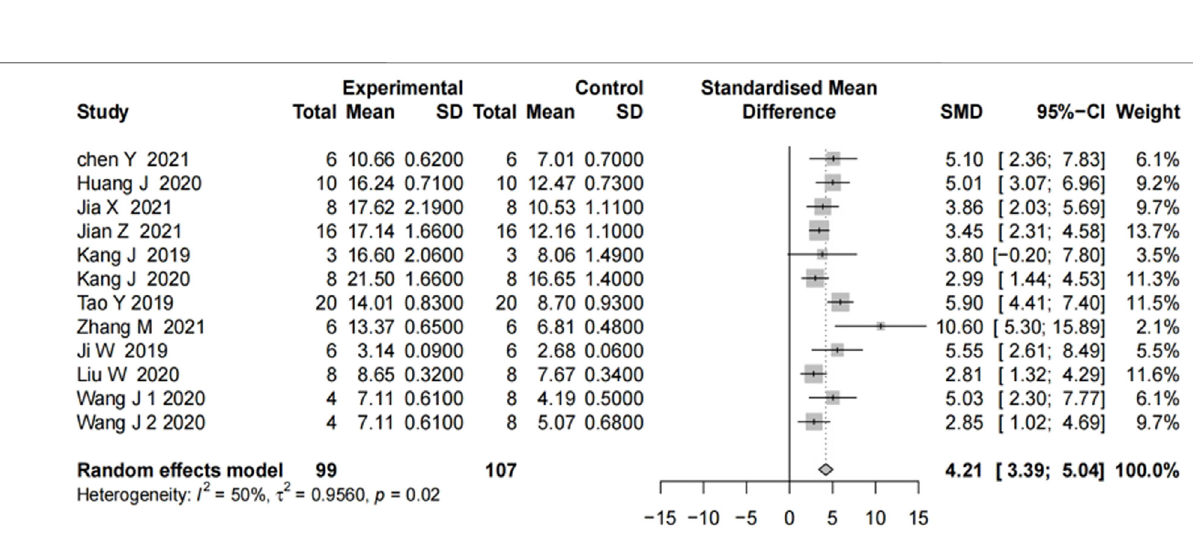
Frontiers in Bioengineering and Biotechnology |